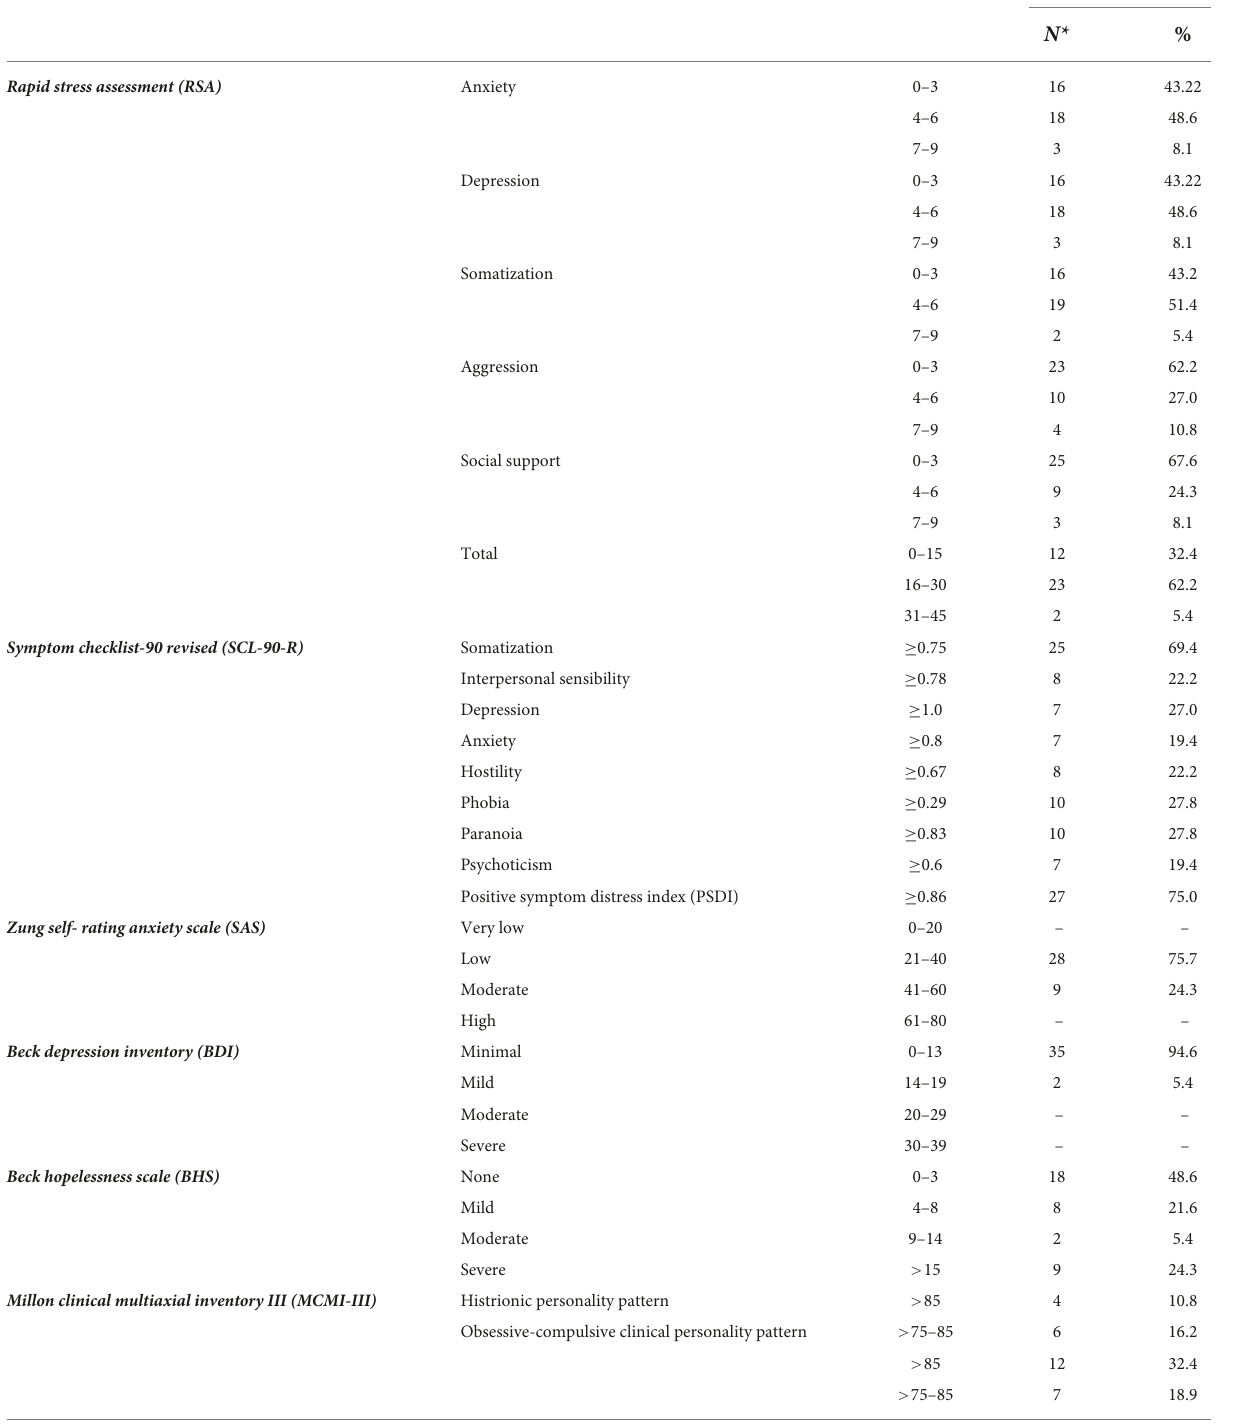
TABLE 1 Psychological assessment of intensive care unit (ICU) medical doctors ( n =